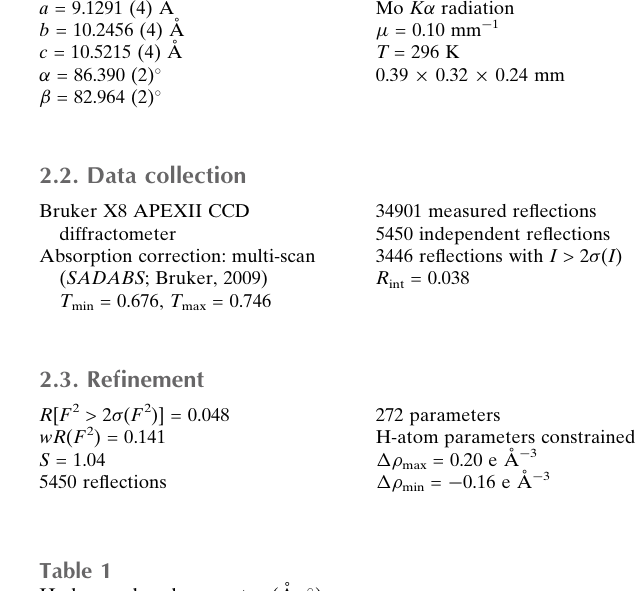
Hydrogen-bond geometry (A˚ , (cid:2)